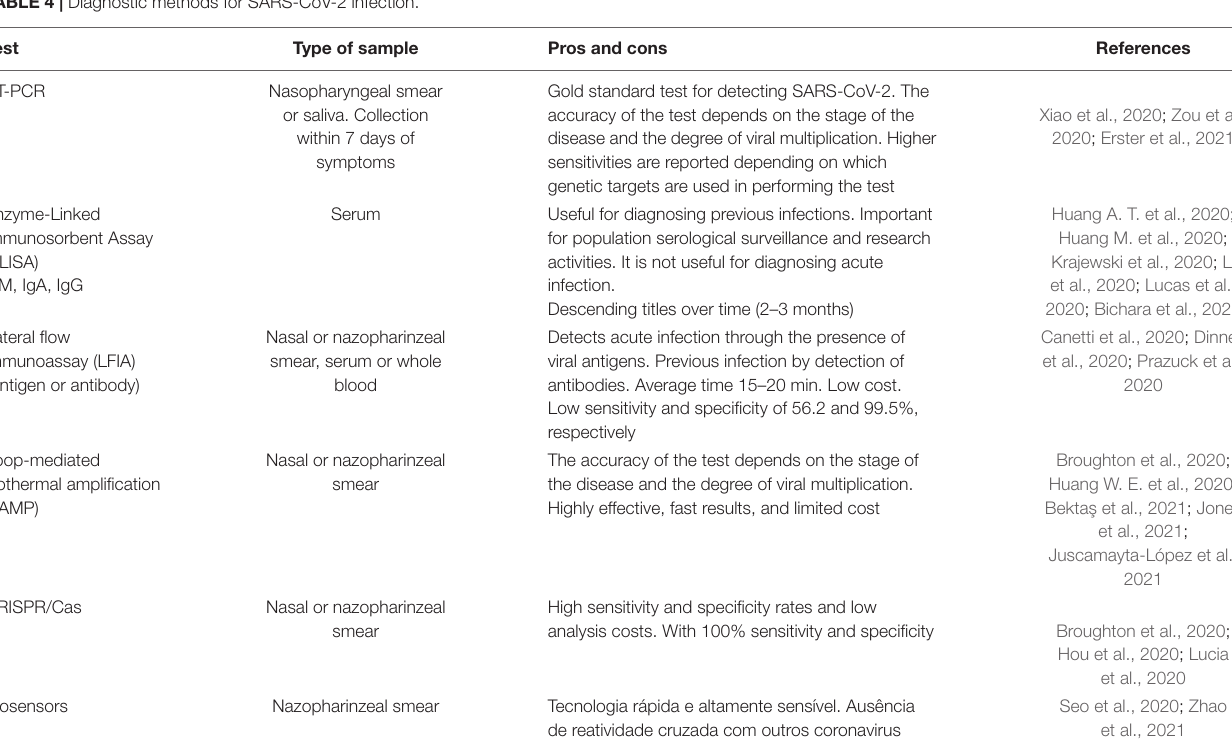
FIGURE 2 | Flowchart for identifying individuals possibly infected with the new coronavirus in the absence of laboratory tests. TABLE 4 | Diagnostic methods for SARS-CoV-2